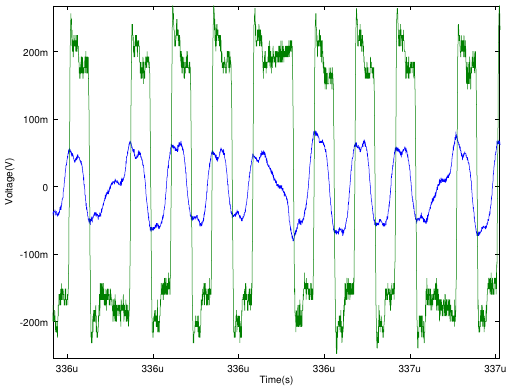
Figure 12: Plot of BER at the receiver before after hard decision